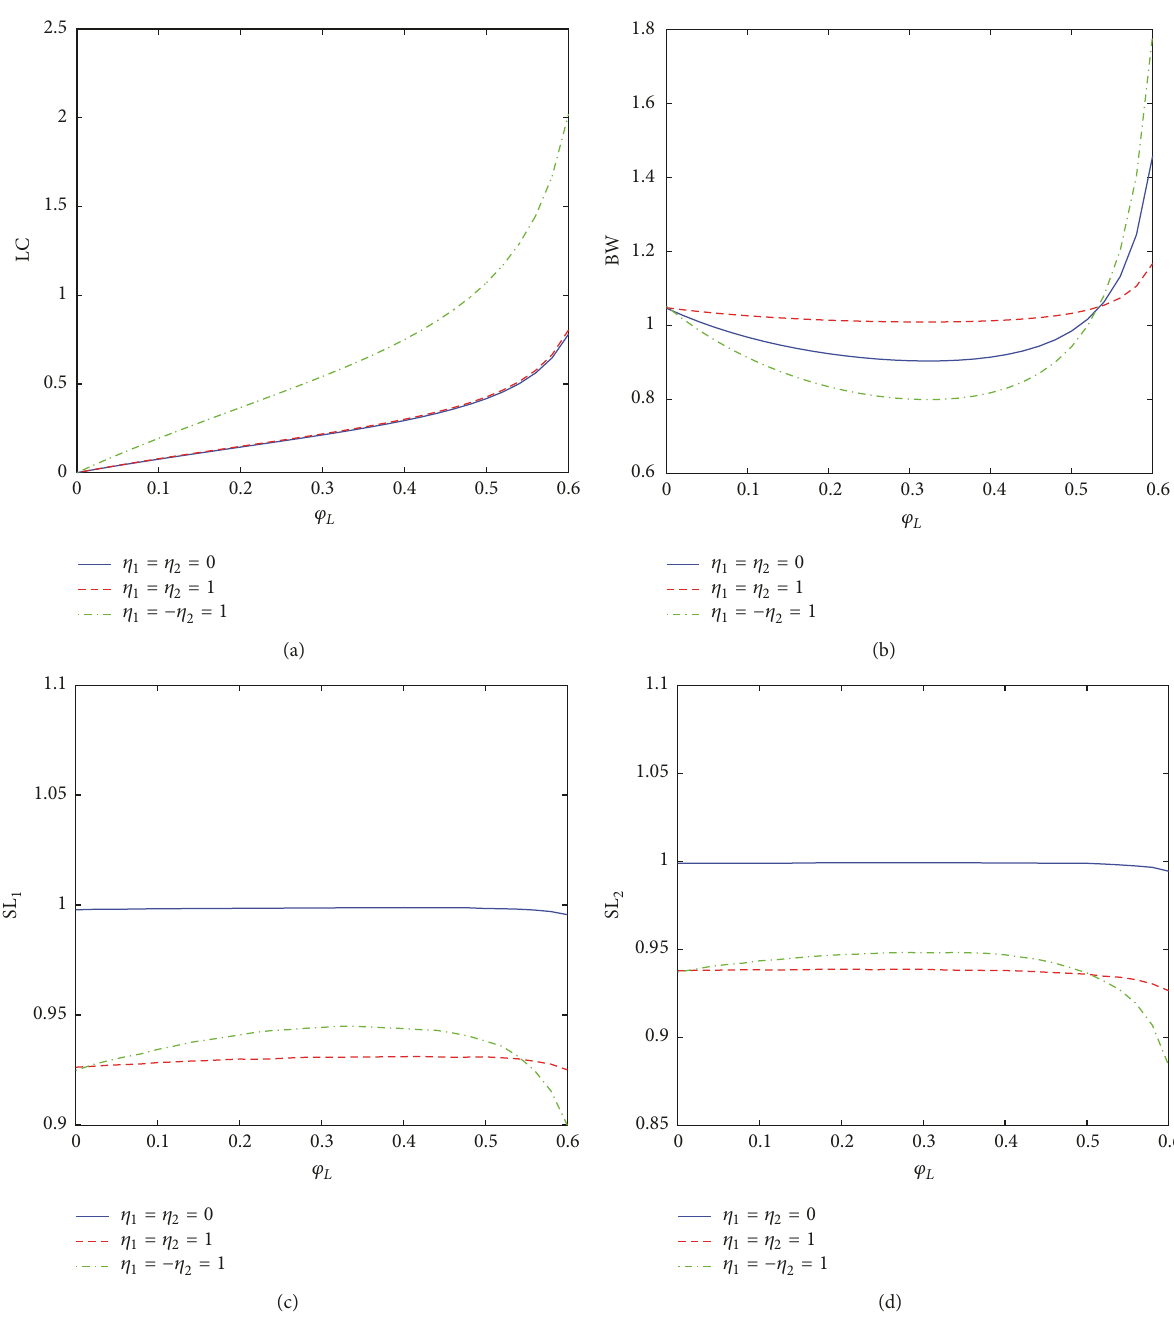
Figure 6: The impact of 𝜑 𝐿 on performance measurements under scenario 𝜉 = 𝜉 1